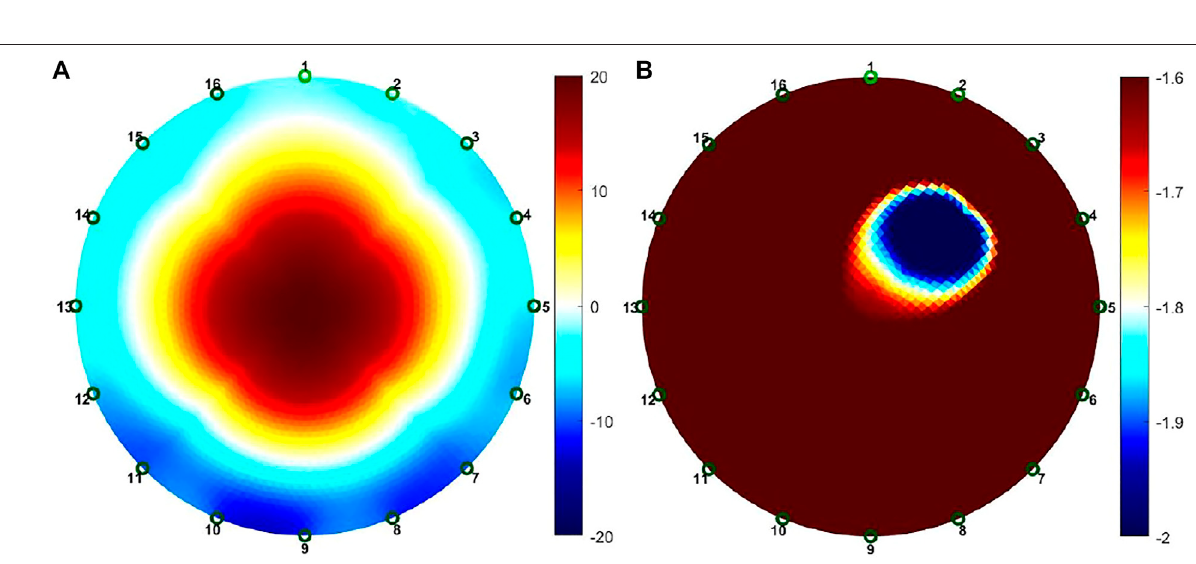
Frontiers in Electronics |